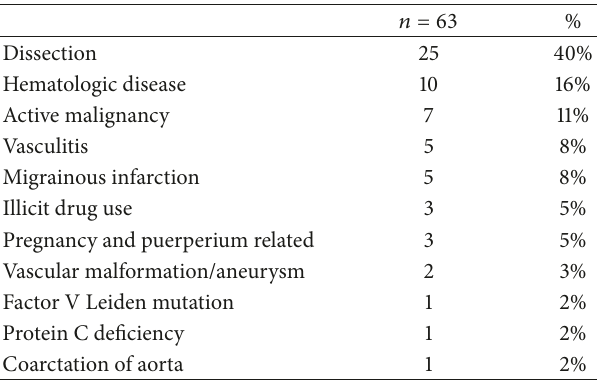
Figure 2: Prevalence of various vascular risk factors according to age in patients with first-ever stroke. Table 3: Subgroups of other determined